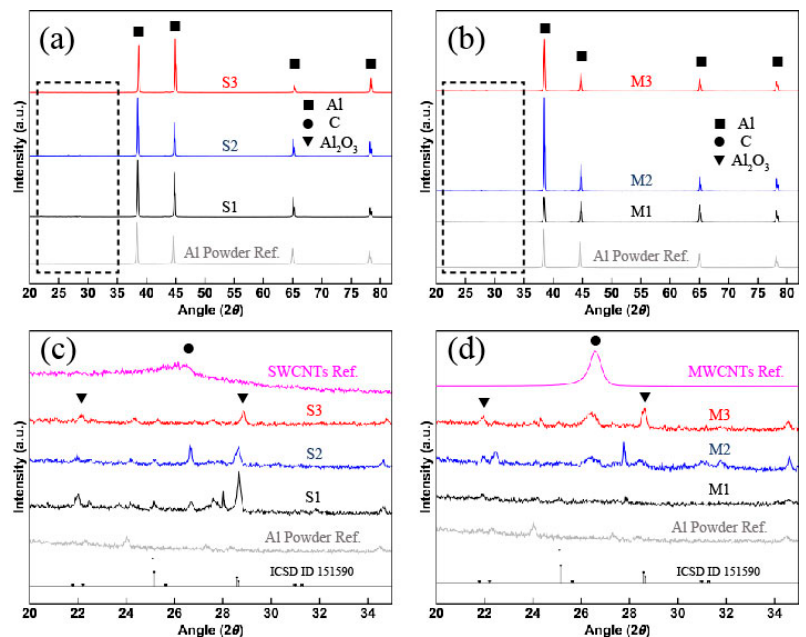
Figure 4. X-ray diffraction (XRD) diffractograms for sintered Al-based composites samples reinforced with ( a ) SWCNT (S1-S3) and ( b ) MWCTNs (M1-M3), showing the characteristic planes for aluminum. ( c ) and ( d ) are the corresponding insets of ( a ) and ( b ), respectively; it is possible to note the characteristic (002) plane for graphitic nanostructures detected in sintered samples. The diffractograms measured for SWCNTs, MWCNTs and Al 2 O 3 (ICSD ID 151590) references were scaled for comparison.